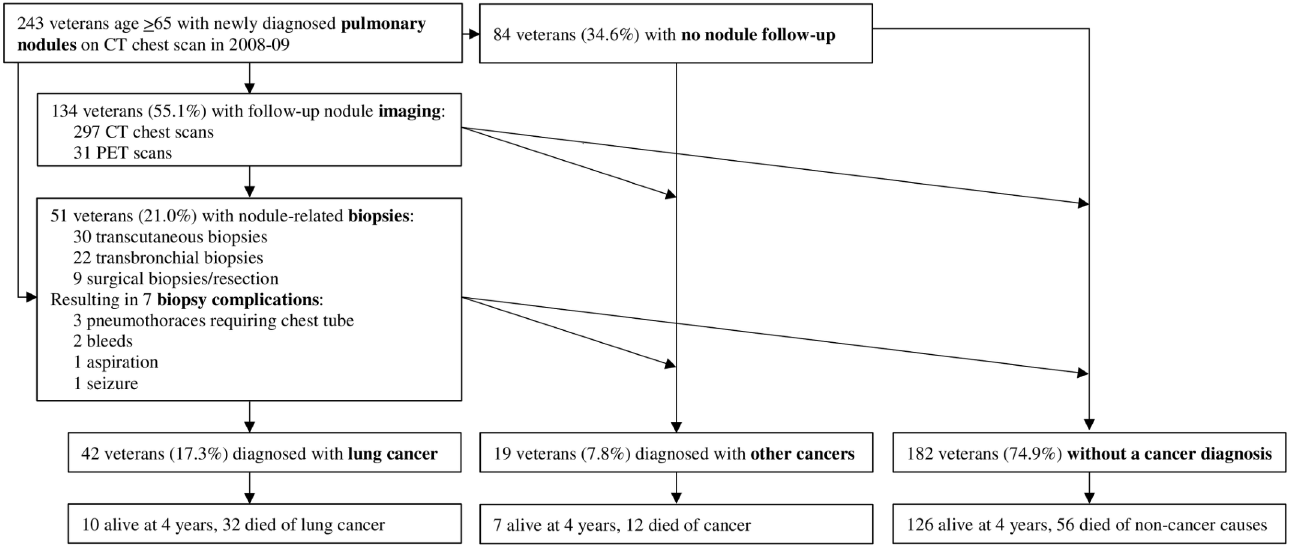
Fig 2. Four-year follow-up after pulmonary nodule diagnosis in veterans age (cid:21) 65 with newly diagnosed pulmonary nodules at the SFVAMC in 2008–09.